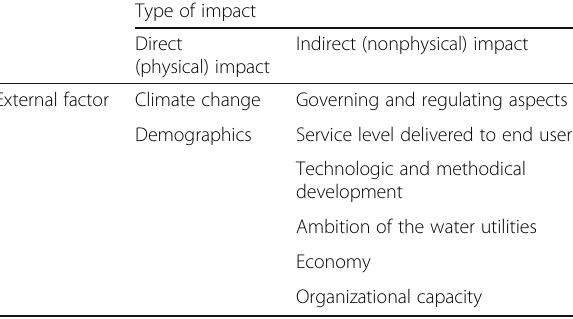
Table 1 Building blocks (external factors) for building future scenarios relevant for the urban water and wastewater